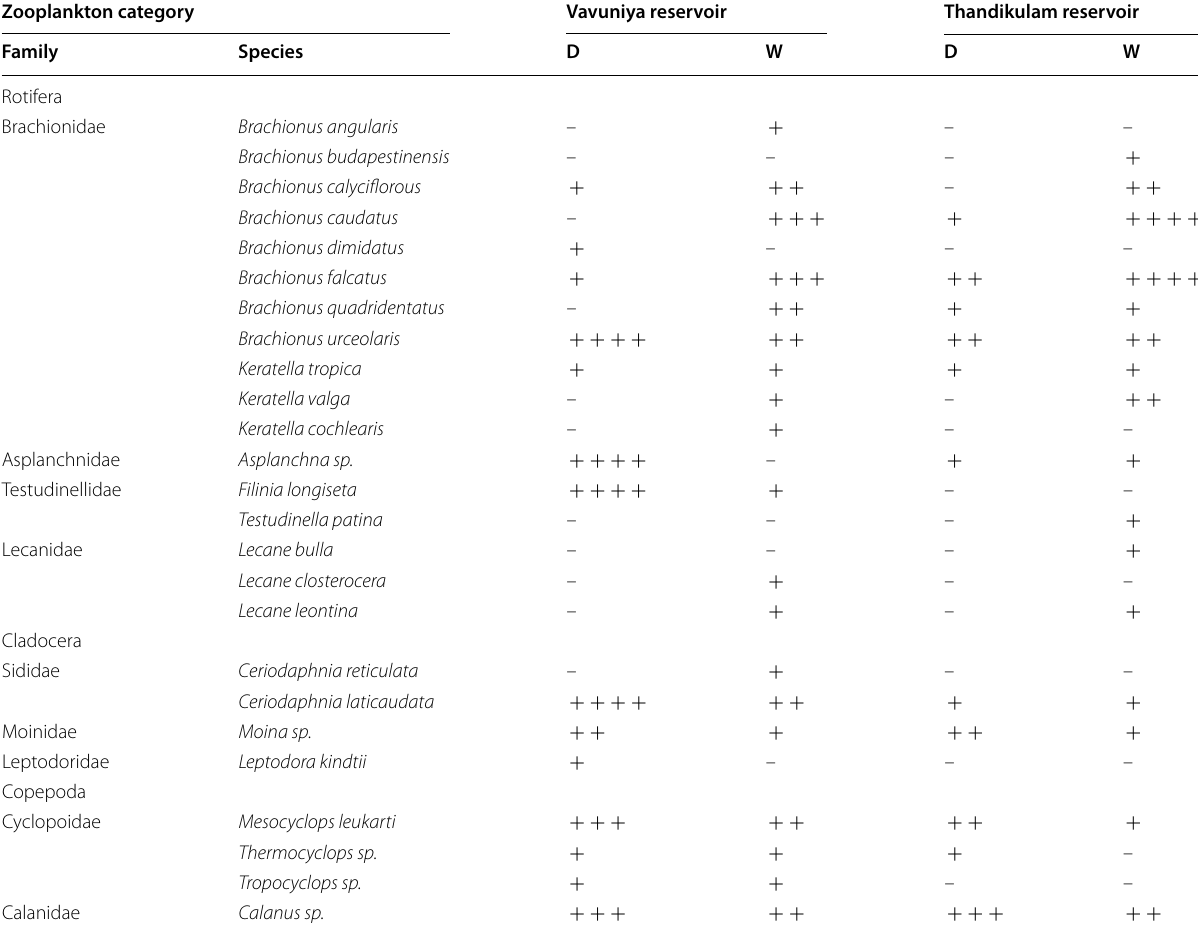
Table 1 Zooplankton species composition in Vavuniya and Thandikulam reservoir during July 2018–February